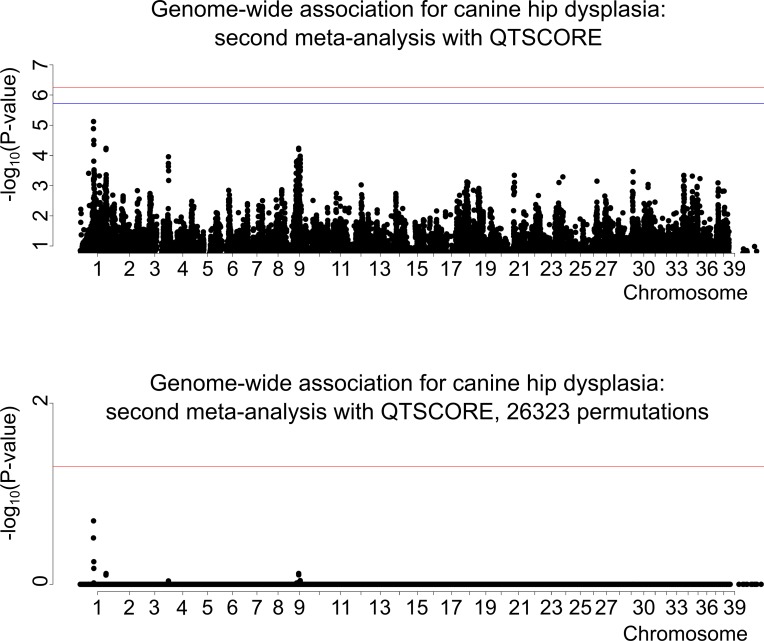
Genome-wide association for canine hip dysplasia: Second meta-analysis, N(cases) = 247, N(controls) = 277.For the upper figure segment the red horizontal line is the threshold for Bonferroni correction for significance. The blue horizontal line is the threshold for significance for independent tests. In the undermost segment, where the permuted P-values are shown, the single red line represents the threshold for genome-wide significance level of 0.05.